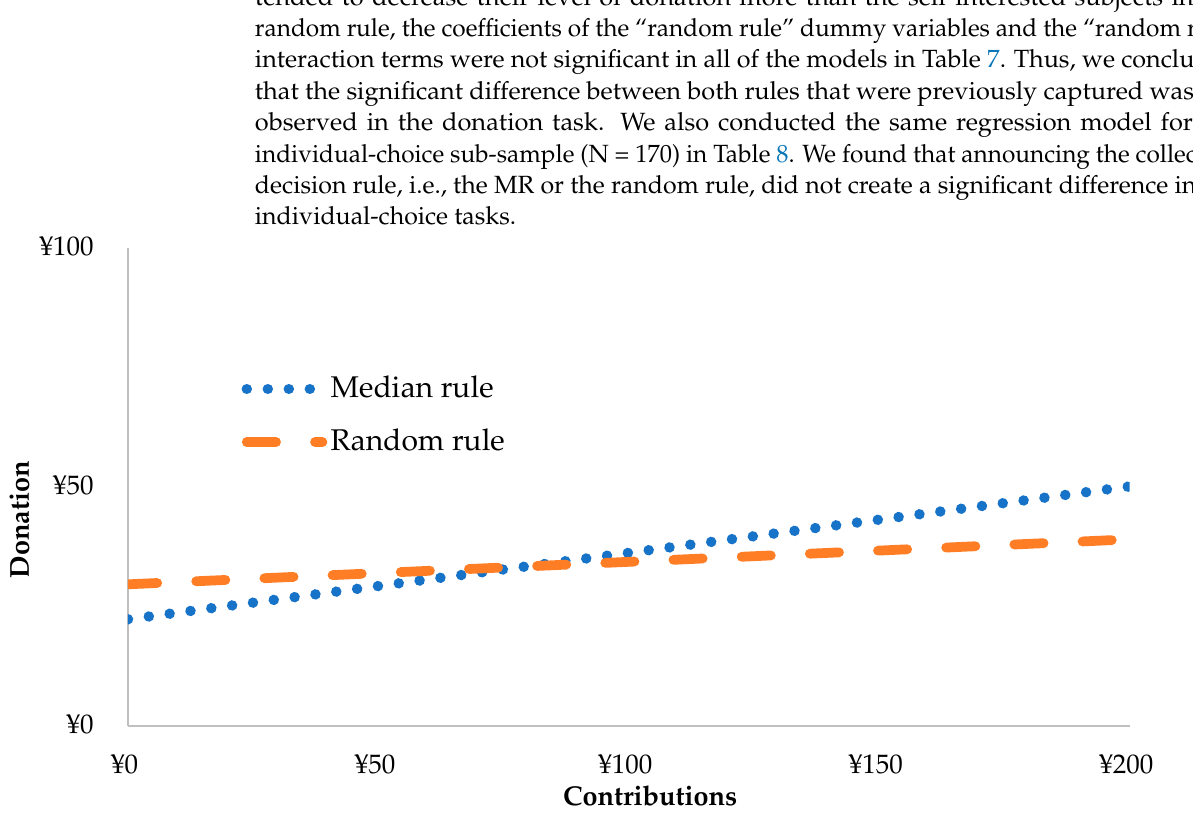
Figure 3. Scatter plots with a regression line: Donation (Group-choice sub-sample) . Table 8. Estimation results for the individual-choice sub-sample (Tobit model) .